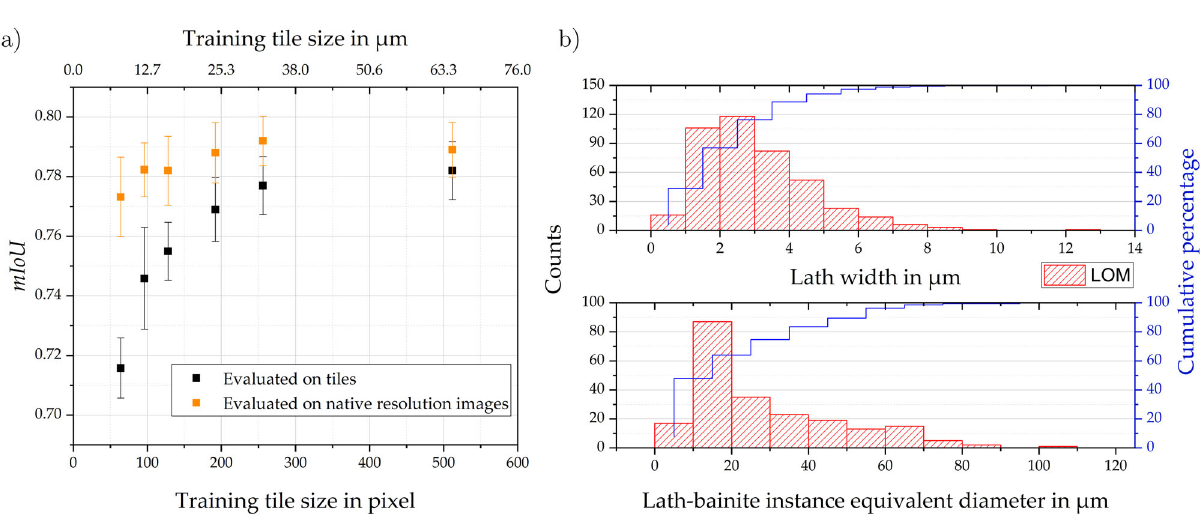
Fig. 2 In fl uence of tile size on the network performance under consideration of microstructure feature sizes. a In fl uence of tile size during training on the mean intersection over union metric (averaged over both classes) for the light optical microscopy domain and the vanilla U-Net model. Evaluation on tiles with a size equivalent to the training tile size (black) and evaluation on native resolution images was performed. Each data point and the error bar corresponds to the average and standard deviation over fi ve folds. b Lath width and lath-bainite instance equivalent diameter histograms including a cumulative percentage for